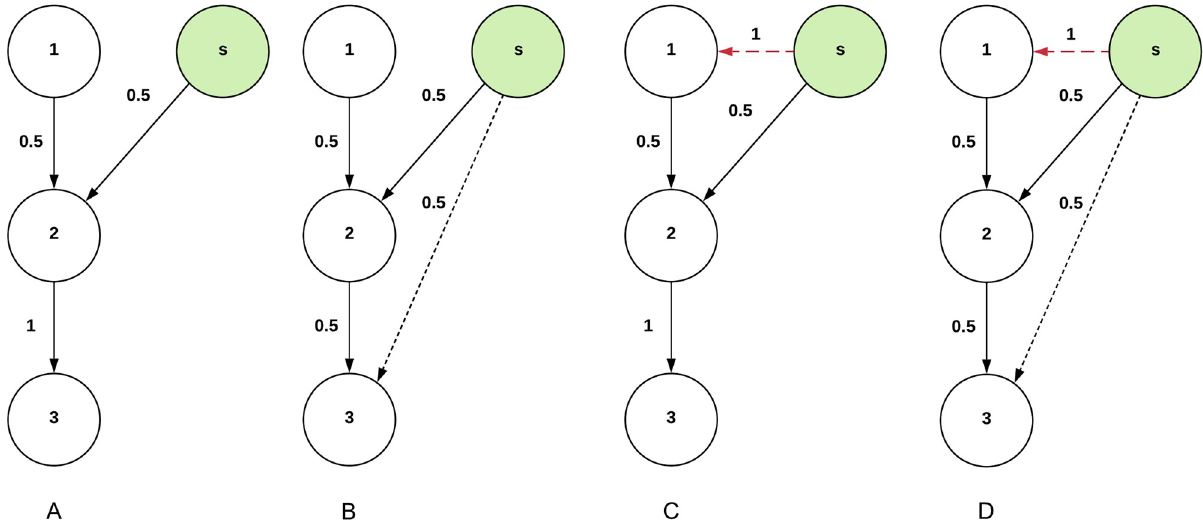
Fig 1. LIM: An example of how the addition of edges affects the network structure and weights of other edges. The circles represent nodes, in which the green circle is the spreader. The arrows represent edges and the numbers next to the arrows are the respective normalized weights. The striped and the red striped arrows depict new edges. A: Graph G . B: G + edge ( s , 3). C: G + edge ( s , 1). D: G + edges ( s , 1), ( s , 3).